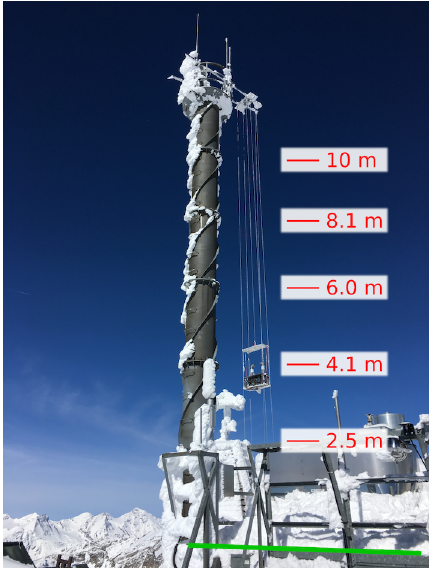
Figure 2. Setup of the elevator with the holographic imager HOLIMO mounted on the meteorological tower at the SBO (cour- tesy of Monika Burkert, ETH Zürich). The red lines and numbers indicate the five different heights at which the elevator was repeat- edly positioned to obtain vertical profiles of the ICNC. The refer- ence height of 0.0m is the bottom of the measurement platform (green